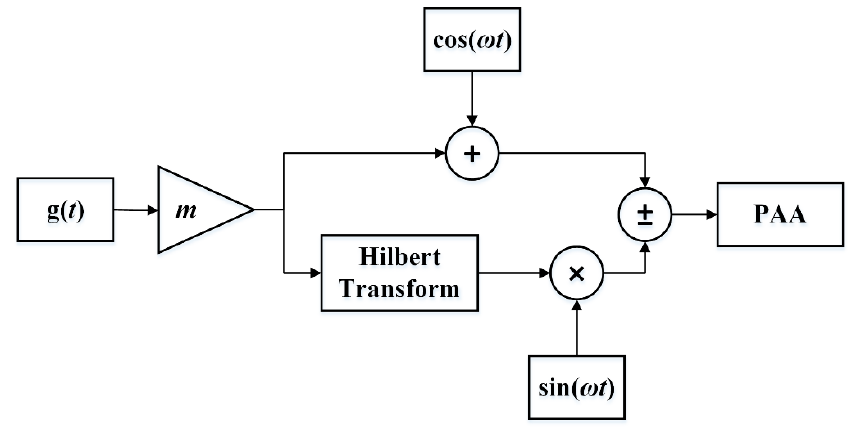
Figure 7. Block diagram of SSBAM.